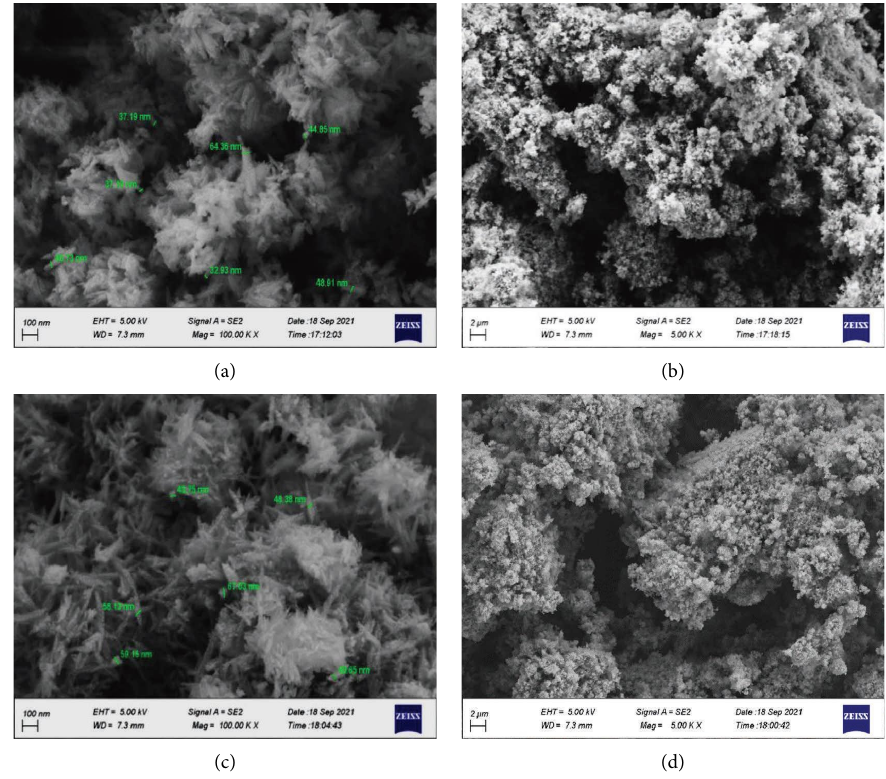
Figure 4: Images of FESEM (a) HA with particle size, (b) HA, (c) Nd-Ce/HA with particle size, and (d)